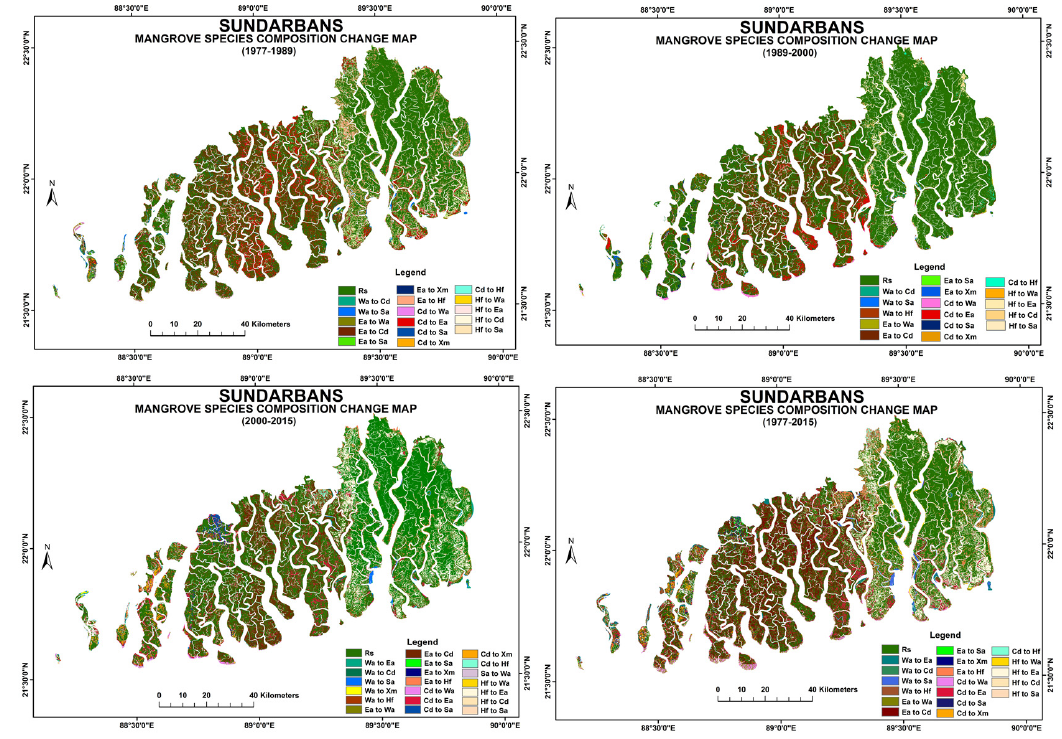
Figure 5. Mangrove species composition change map of the Sundarbans mangrove forest (Rs = Remained the same, Wa = Water, Ea = Excoecaria agallocha , Cd = Ceriops decandra , Sa = Sonneratia apelatala , Xm = Xylocarpus mekongensis , Hf = Heritiera fomes ).